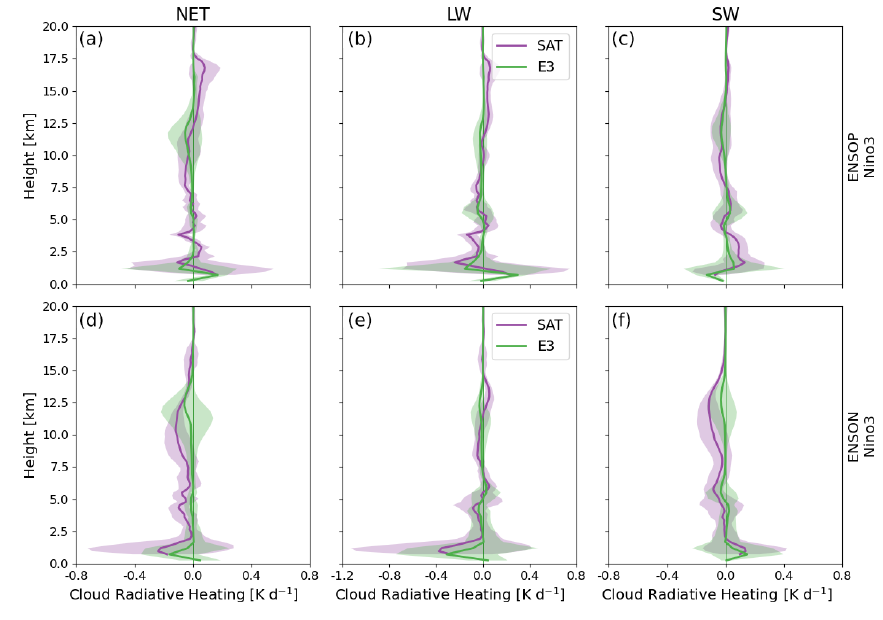
Figure 11. Same as Fig. 10 but averaged over the Niño3 region.